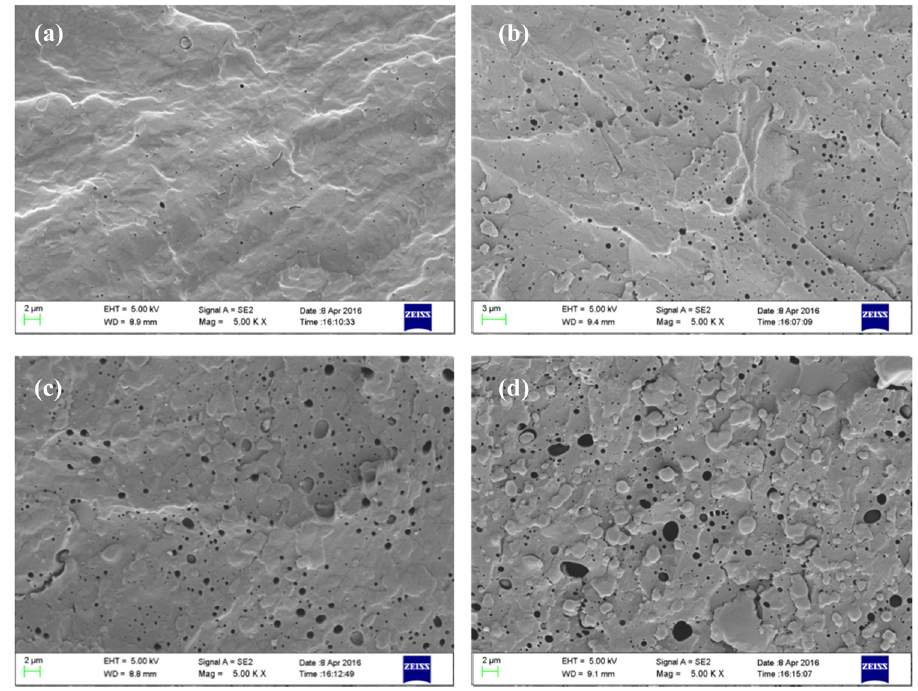
Figure 2: Fracture surfaces of ( a ) PVA/P ( 3HB - co - 4HB ) ( PVA 95 wt% ) , ( b ) PVA/P ( 3HB - co - 4HB ) ( PVA 90 wt% ) , ( c ) PVA/P ( 3HB - co - 4HB ) ( PVA 80 wt% ) , and ( d ) PVA/P ( 3HB - co - 4HB ) ( PVA 70 wt% )